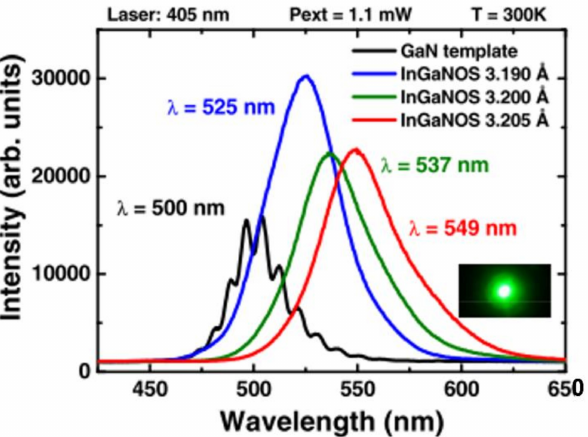
Figure 5. PL wavelength comparison of MQWs grown on InGaNOS and GaN template. The figure is reproduced from [16], with the permission of AIP